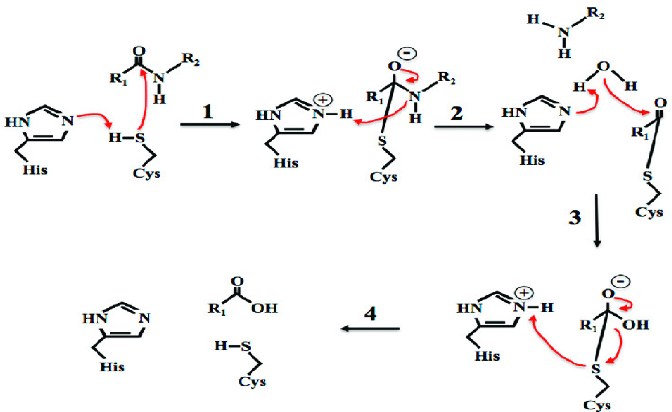
Figure 2. The classic cysteine protease reaction mechanism. Adopted from [44].